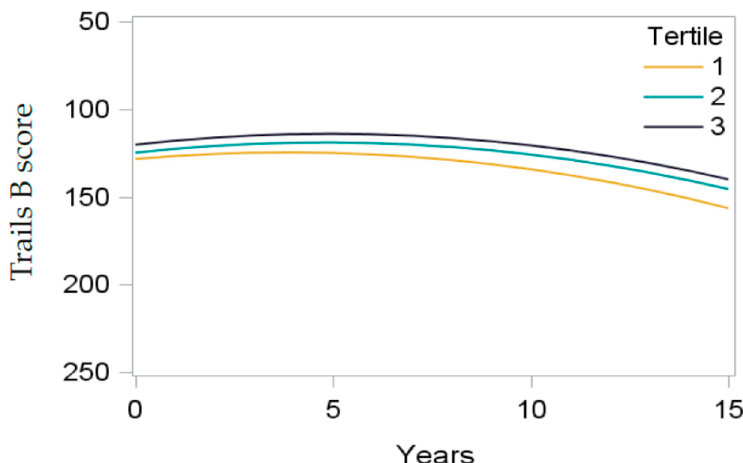
Figure 1. Modeled trajectories of Trails B performance over time as a function of plant polyunsatured fatty acid/vitamin E factor score tertile. Plots are based on all model coefficients using plant PUFA/vitamin E factor score tertile group-specific mean values for covariates: age, sex, education, total energy intake and practice effect. The axis for Trails B is reversed so that downward sloping lines show decreasing performance.